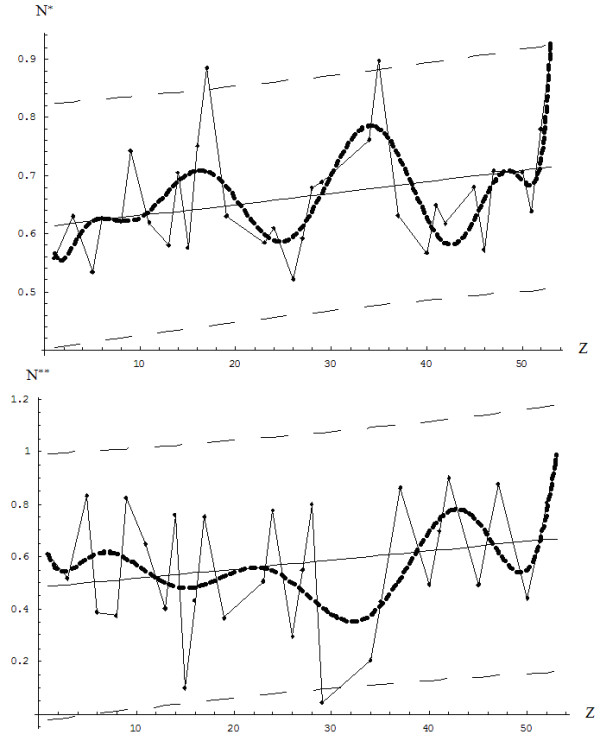
The critical ground state and valence charge points for the elements of Table1and their 10th-order continuous interpolations according to eqs. (45a) and (45b).